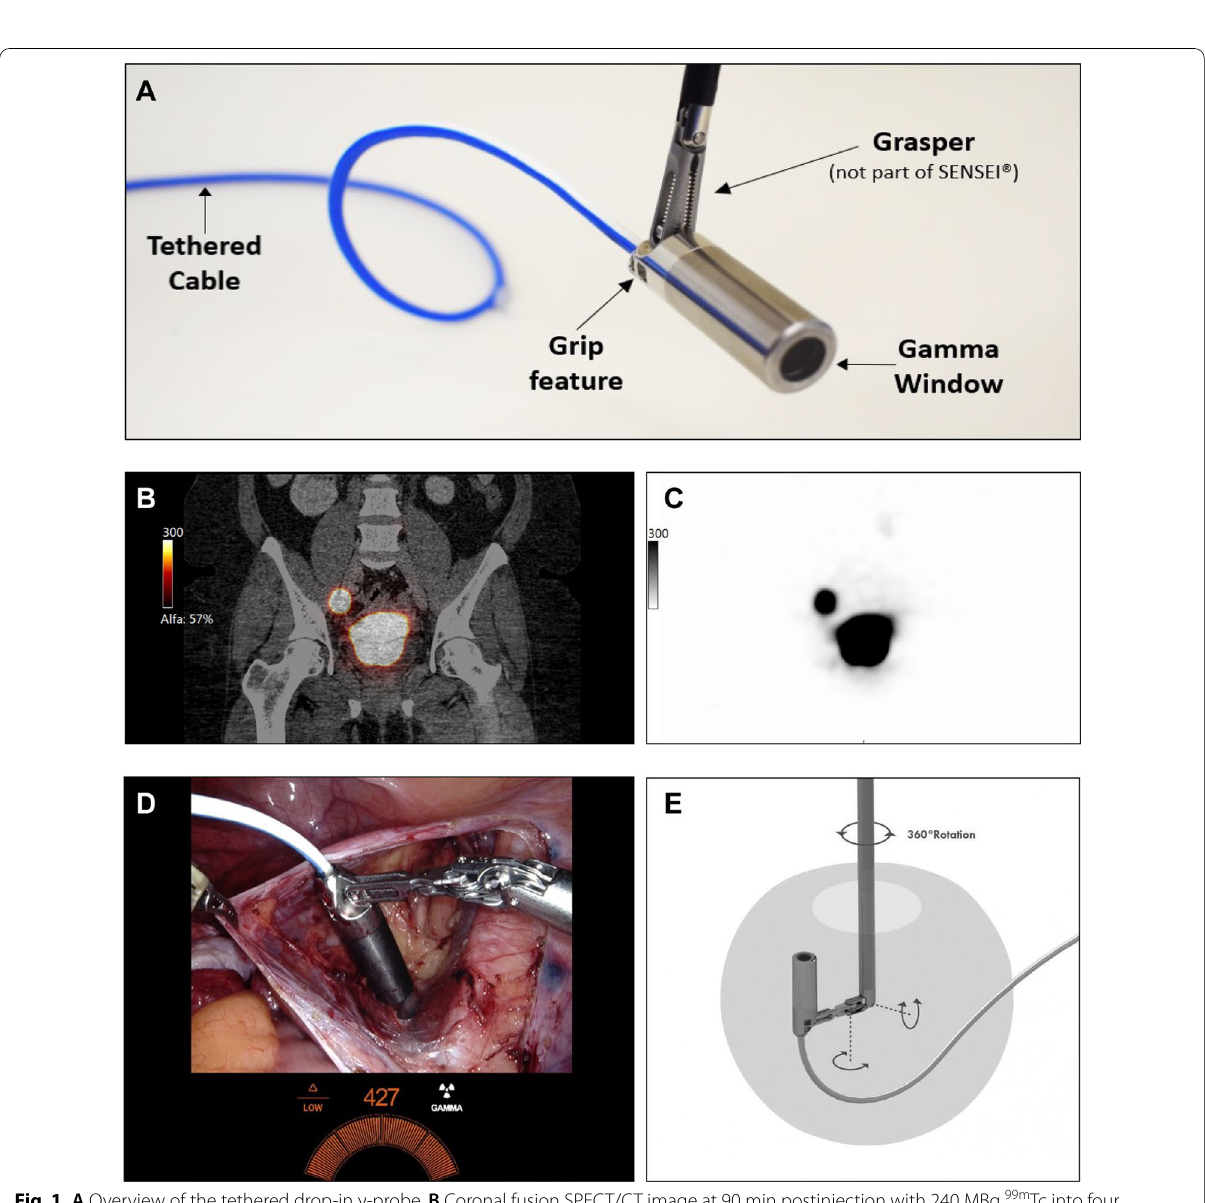
Fig. 1 A Overview of the tethered drop-in γ-probe. B Coronal fusion SPECT/CT image at 90 min postinjection with 240 MBq 99m Tc into four quadrants of the cervix. The right SLN is localized in the obturator fossa. C Corresponding stand-alone SPECT/CT image. D Surgical view of robot-assisted radioguided SLN detection in the right obturator fossa. Integration of the gamma probe signal in the surgical view can be seen in the bottom center. E Rotational features of tethered drop-in γ-probe when